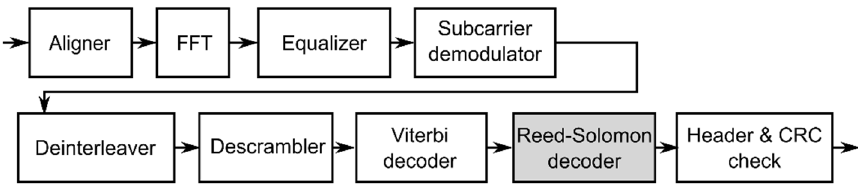
Figure 4. PRIME physical layer reception diagram introducing Reed–Solomon.